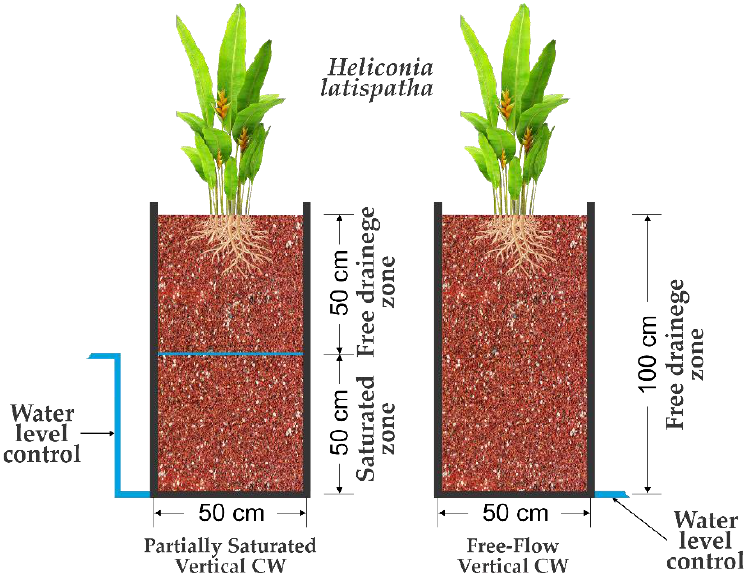
Figure 2. Pilot-scale wetland system configuration: free-drainage zone and saturated zone.